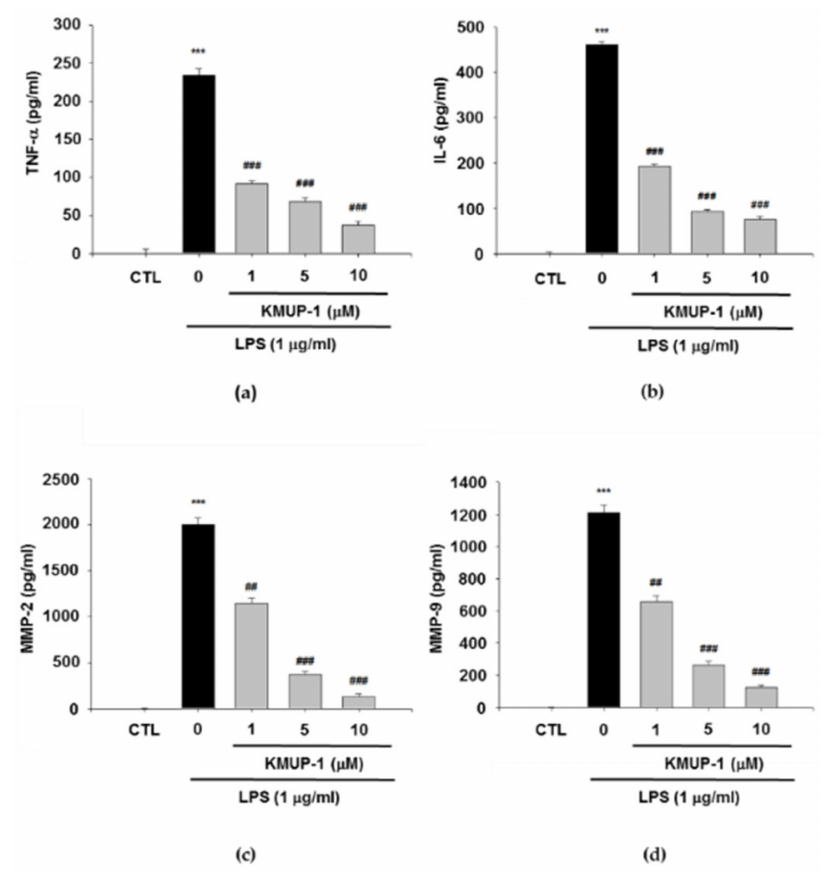
Figure 2. Effects of KMUP-1 on inflammatory cytokines in LPS-induced RAW 264.7 cells. ( a ) Tumor necrosis factor alpha (TNF- α ), ( b ) interleukin 6 (IL-6), ( c ) matrix metalloproteinase-2 (MMP-2), and ( d ) matrix metalloproteinase-9 (MMP-9) in the culture media were evaluated by ELISA assay. Values are presented as mean ± SEM, n = 3. *** p < 0.001 compared to control group. ## p < 0.01 and ### p < 0.001 compared to LPS